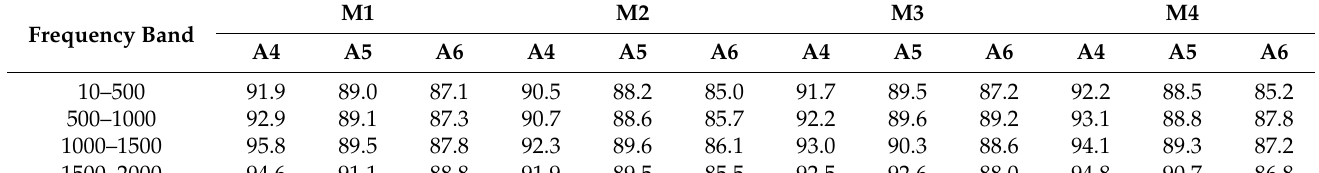
Table 8. The overall sound pressure level in different frequency bands (dB). Frequency Band